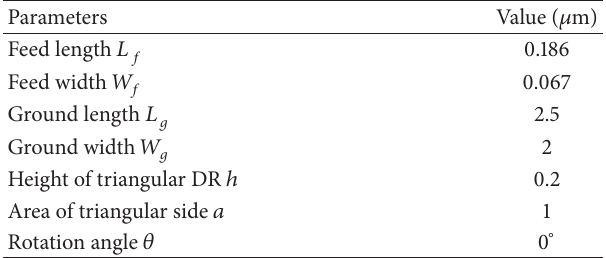
Table 1: Optimized parameters of